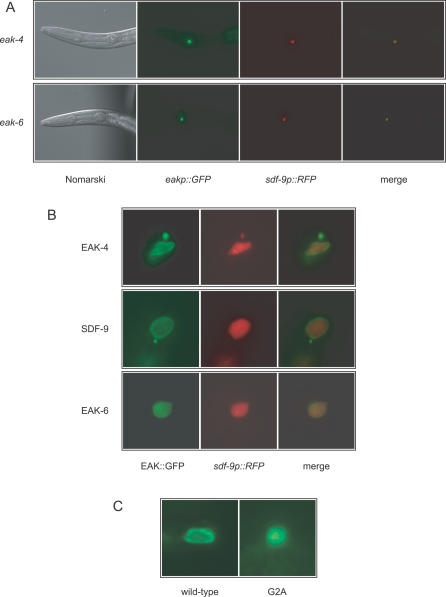
EAK-4, SDF-9, and EAK-6 Localize to the Plasma Membrane of the XXX Cells(A) eak-4, sdf-9, and eak-6 promoters drive expression in the same cells. Wild-type animals harboring an extrachromosomal array with eakp::GFP and sdf-9p::RFP constructs were analyzed by fluorescence microscopy. Representative photographs are shown. Animals are oriented anterior left and dorsal up.(B) EAK-4::GFP, SDF-9::GFP, and EAK-6::GFP fusion proteins localize to the plasma membrane of XXX. Animals harboring EAK::GFP translational fusion constructs and an integrated sdf-9p::RFP array were analyzed using fluorescence microscopy. Representative photographs of a XXX cell are shown.(C) Mutation of the invariant glycine in the N-myristoylation motif of EAK-4 abrogates plasma membrane localization. Animals harboring either a wild-type EAK-4::GFP construct or an EAK-4::GFP construct with the glycine at position 2 mutated to alanine (G2A) were analyzed using fluorescence microscopy.